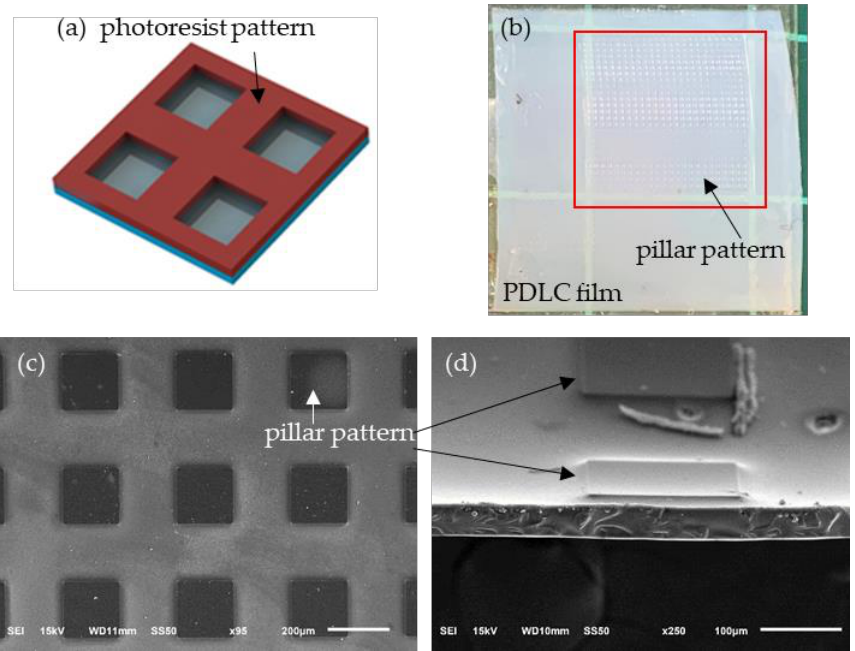
Figure 1. ( a ) Schematic drawing of glass substrate with photoresist pattern; ( b ) image of patterned PDLC film; ( c ) SEM image of top view of patterned PDLC film; ( d ) SEM image of section view of patterned PDLC film.